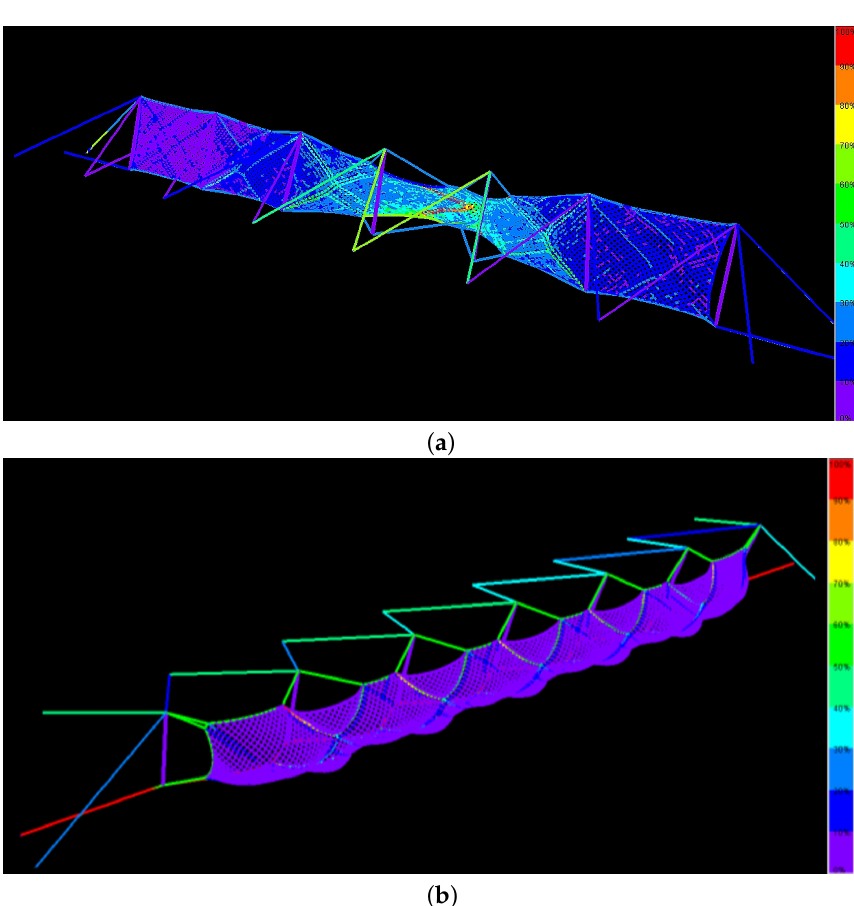
Figure 2. ( a ) Numerical simulation of a certified flexible rockfall protection system. The colour spectrum shows the degree of utilisation of the single barrier components (blue = 0–10% until red = 90–100%). ( b ) The unusual load case of a shallow landslide can be checked in addition. The two simulations show the different reaction of the barrier regarding the different types of loads: the rockfall loads mostly the impact section only, whereas the landslide stresses the upslope ropes over the full barrier length.